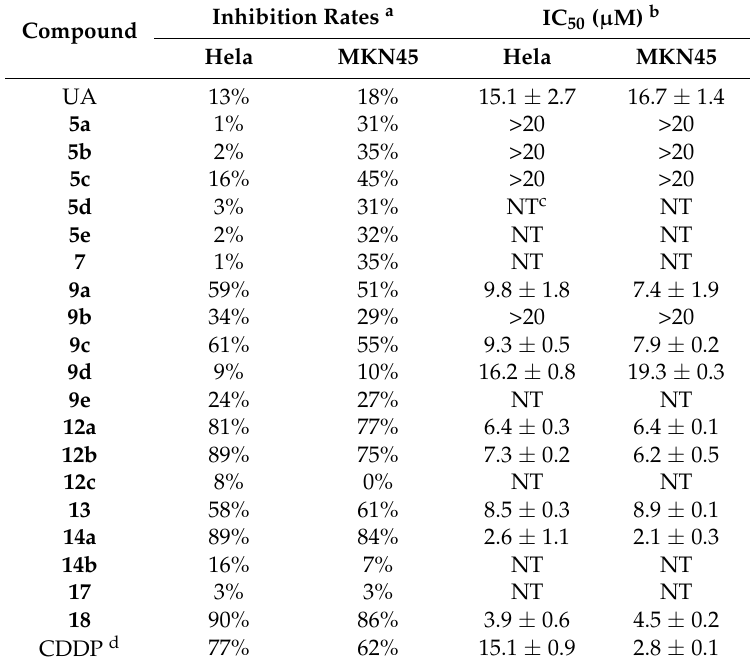
Table 1. Cytotoxic activities of the compounds against Hela and MKN45 cell